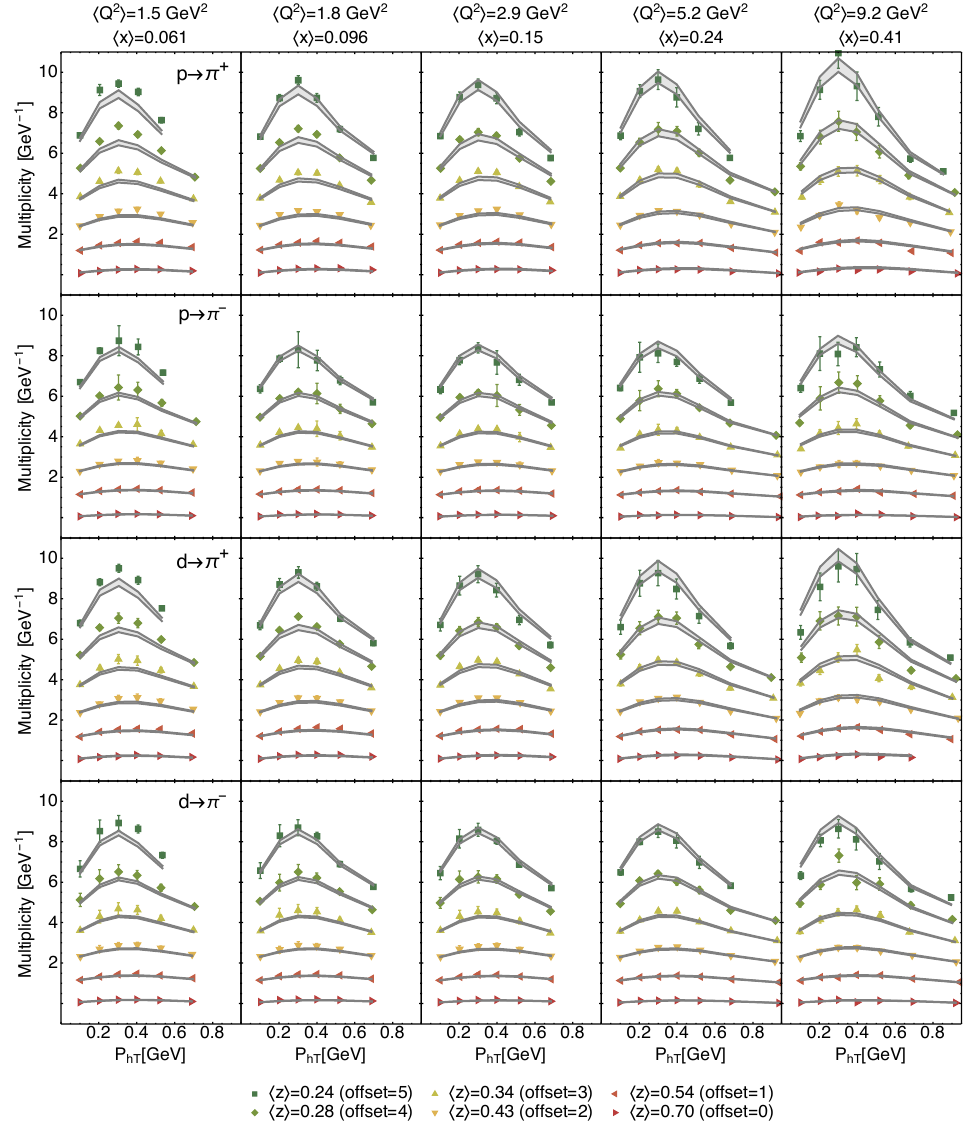
Figure 3 . Hermes multiplicities for production of pions off a proton and a deuteron for different x , z , and Q 2 bins as a function of the transverse momentum of the detected hadron P hT . For h i h i h i clarity, each z bin has been shifted by an offset indicated in the h i